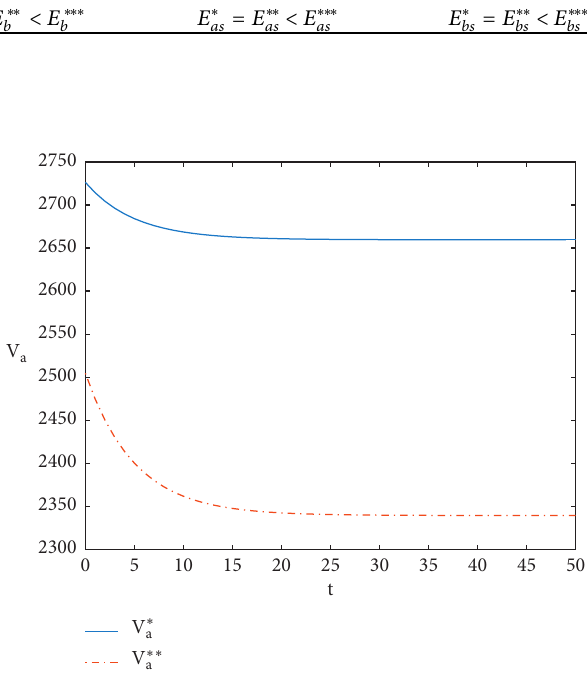
Figure 3: Comparison of environmental pollution losses of Local- gov A.